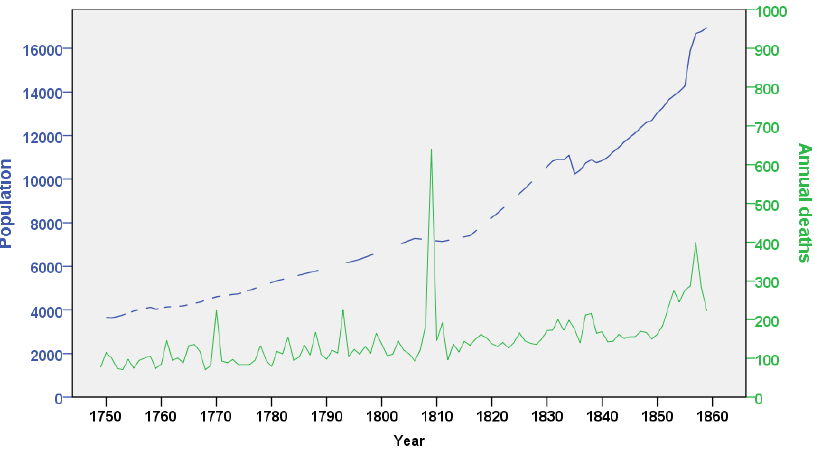
Figure 2. Population changes over time, Skellefteå